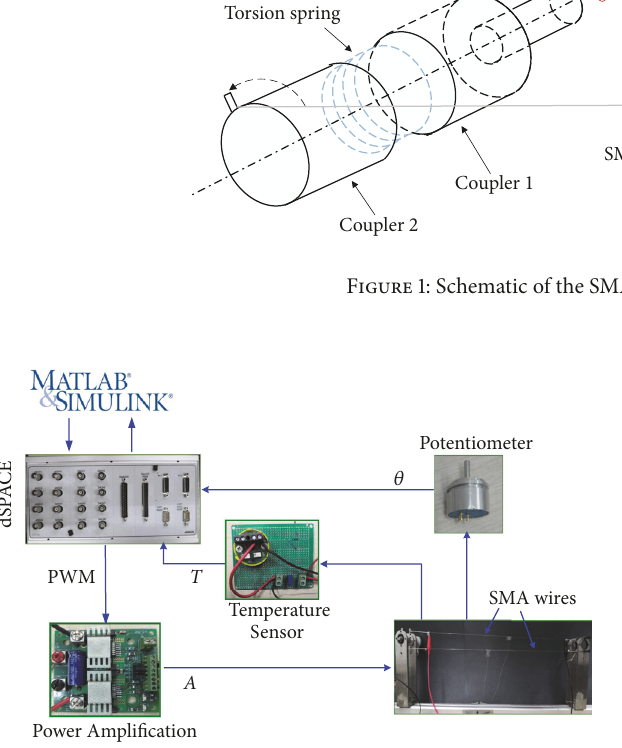
Figure 2: Experimental platform of the SMA-based compliant